Question: Summarize what this figure shows in one sentence.
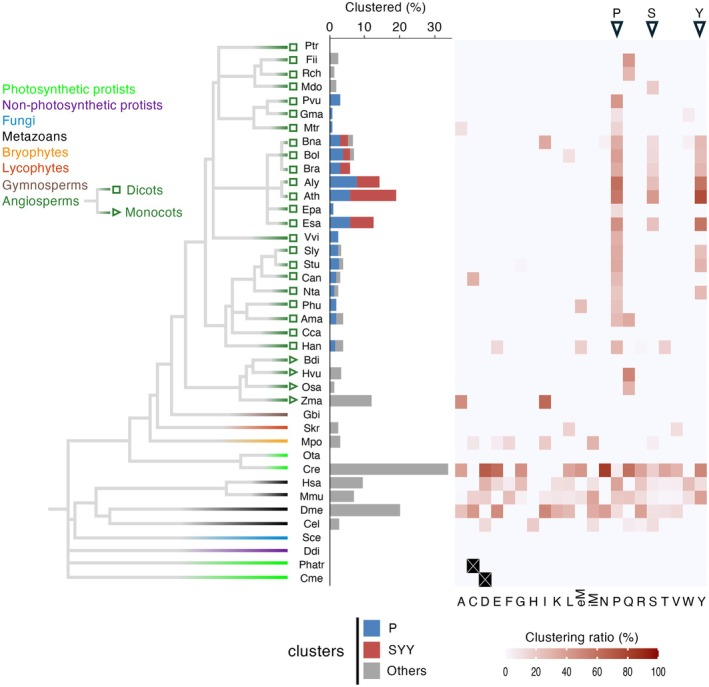
Answer: Comparative analysis of tDNA clustering across species and isotype families. Histogram showing the percentage of total clustered tDNAs in each species (left) and heat map showing the clustering ratio of tDNA isotypes in each species (right), under the clustering criterion ≥5 genes within 5 kb. White indicates the absence of clustering (all genes isolated), whereas dark red indicates complete clustering (all genes grouped), with the color scale representing clustering ratio (%) from 0 to 100. White arrows point to three tDNA isotype families (proline/P, serine/S, and tyrosine/Y) that frequently cluster in angiosperms (see blue and red histogram). In Cyanidioschyzon merolae (Cme) and Phaeodactylum tricornutum (Phatr), asparagine (D) and cysteine (C) tDNAs could not be confidently annotated and were excluded from the analysis (black crossed‐out boxes). Complete results for all clustering criteria are provided in Figure S10 .